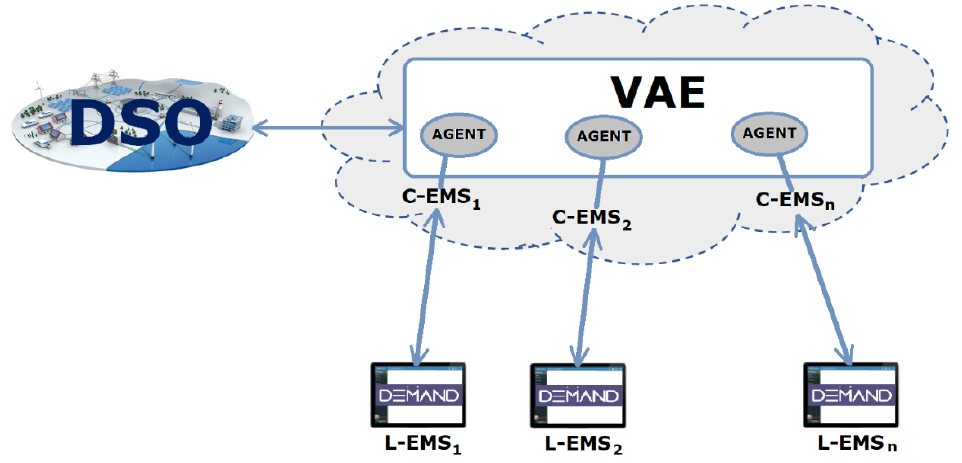
Figure 2. Interaction between EMS and VAE.